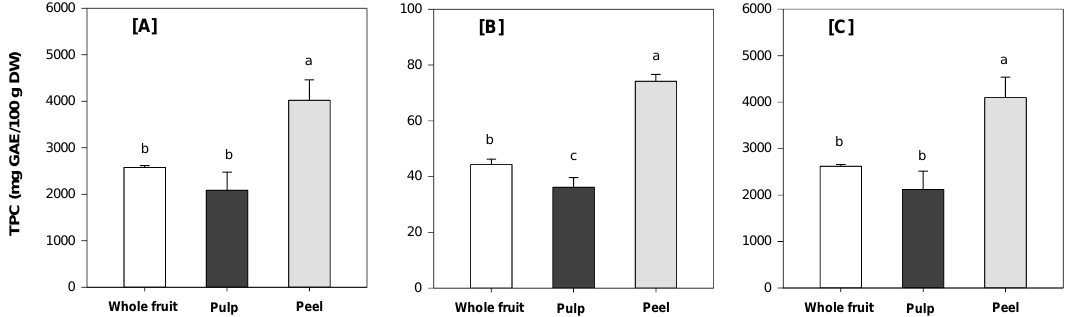
Figure 1. Total phenolic content (TPC): ( A ) Free, ( B ) Bound and ( C ) Total (free + bound) in powdered feijoa whole fruit, pulp and peel. The TPC was calculated on dry weight basis. Data are means ± SD ( n = 3). Different letters in the same figure indicate significant differences at α = 0.05.